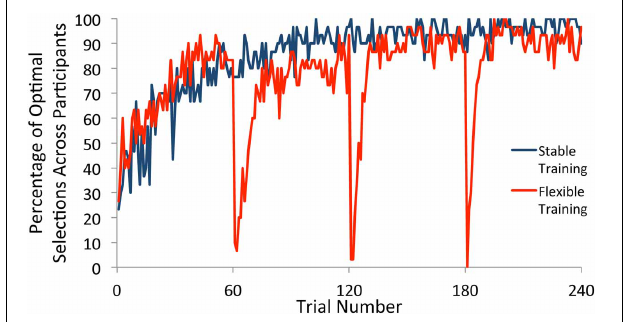
FIGURE 2 | Percentage of participants who selected the optimal square on each trial of the training phase. Participants who received flexible training quickly adjusted their behavior to the new reward contingencies within each block after a switch. Participants who received stable training maintained a single selection rule throughout the task.